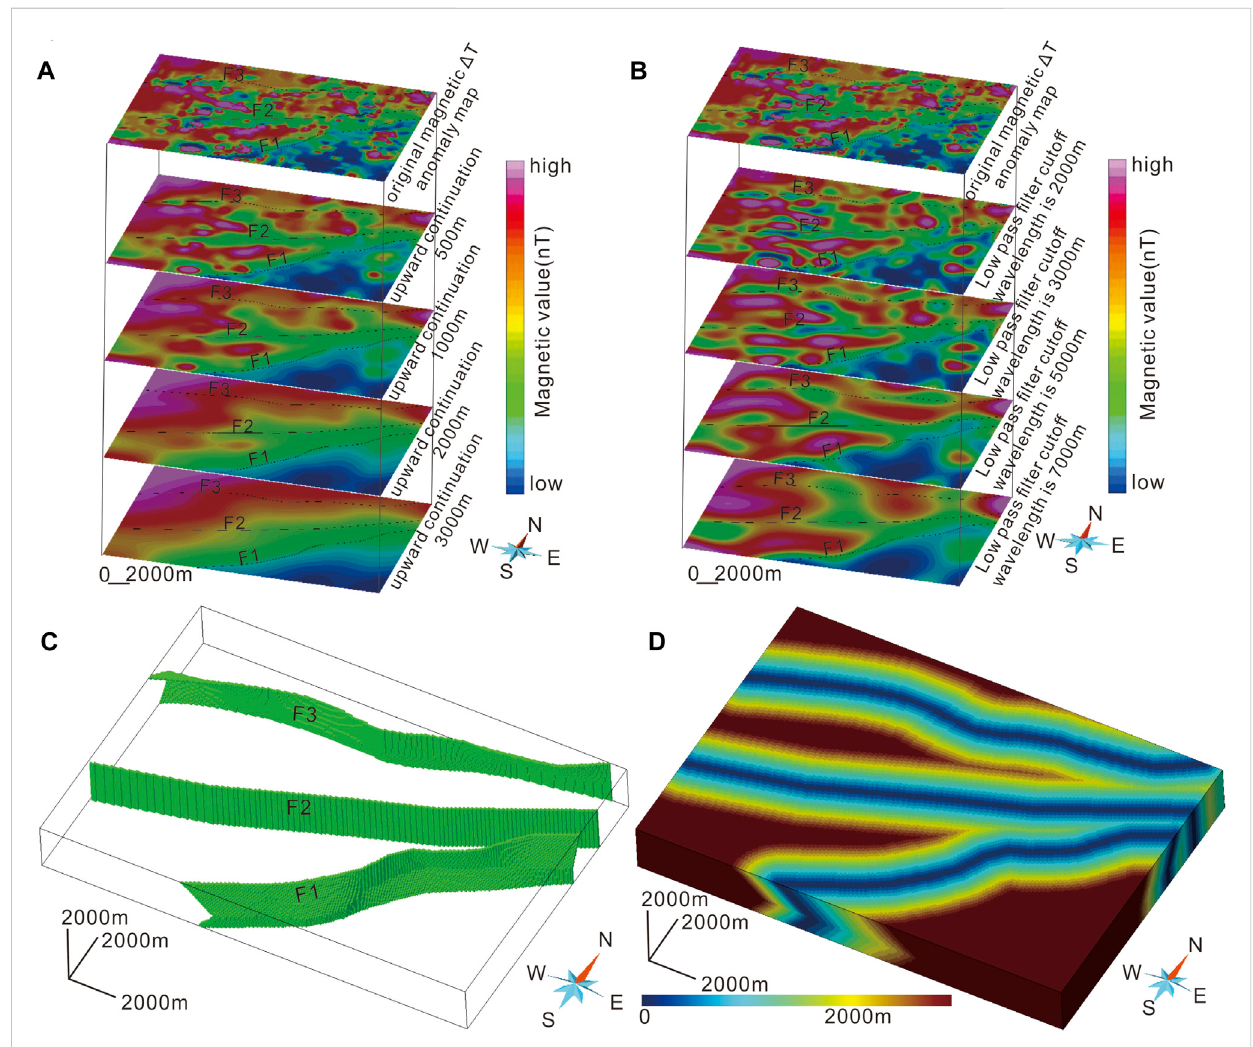
FIGURE 4 Regional fault model of (A) the different depth of upward continuation of magnetic anomaly; (B) low pass fi ltering of magnetic anomaly (C) the 3D regional fault solid model (D) the 3D regional fault buffer